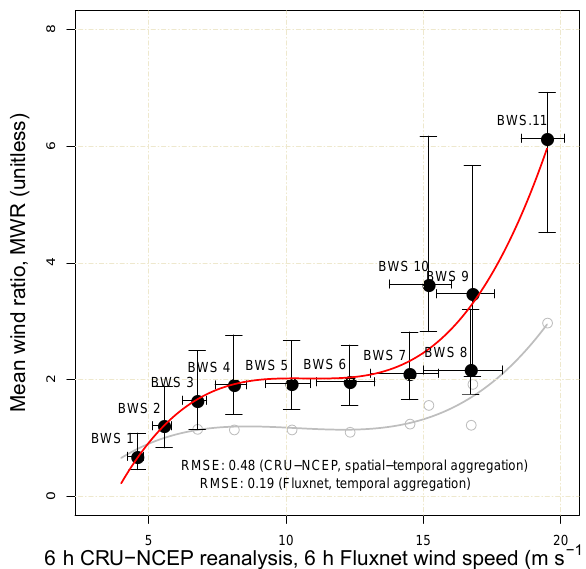
Figure 2. Distribution of the mean wind ratio (MWR) in each Beaufort wind scale (BWS) and the relationship between the 6h CRU-NCEP reanalysis wind speed and MWR. The fitting of the relationship (red line) used Eq. (12) with regression coefficients a 0 = − 5 . 299, a 1 = 2 . 051, a 2 = − 0 . 191, and a 3 = 0 . 006. This re- lationship is used to convert CRU-NCEP 6h mean wind speed to the 30min maximum wind speed in this study. The RMSE using this regression model to predict the mean value of MWR in each BWS class is 0.48. The open circles (grey colour) show the effect of 6h temporal aggregation on the MWR from the selected Fluxnet sites in European forest. The grey line is the fitting line of the open